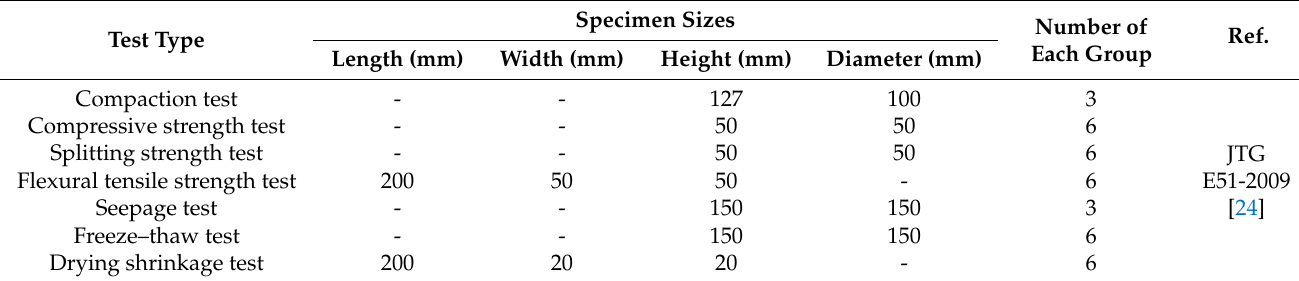
Table 5. Specimen sizes of various